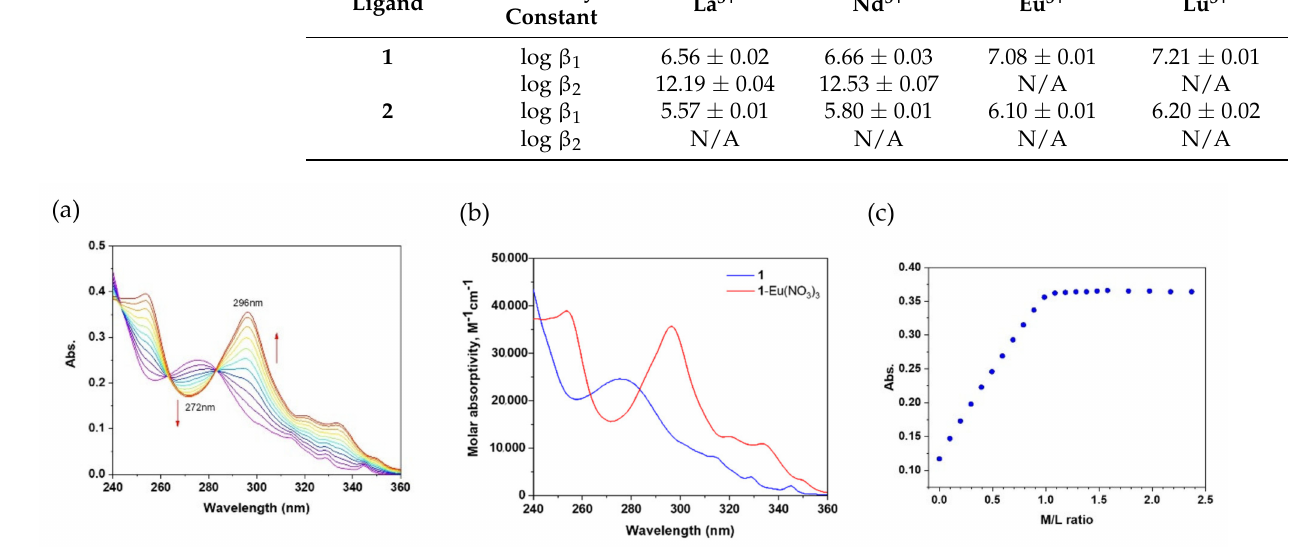
Figure 15. Spectrophotometric titration of 1 (ca. 10 − 5 mol/L) with Eu 3+ ions (ca. 5 × 10 − 4 mol/L) in CH 3 CN solution (T = 25.0 ± 0.1 ◦ C, I = 0 M, V 0 = 2.0 mL): ( a ) absorption spectra; ( b ) molar absorptivities of free ligand 1 and Eu(III) complex calculated from spectral deconvolution; ( c ) titration curve at 296 nm (maximum